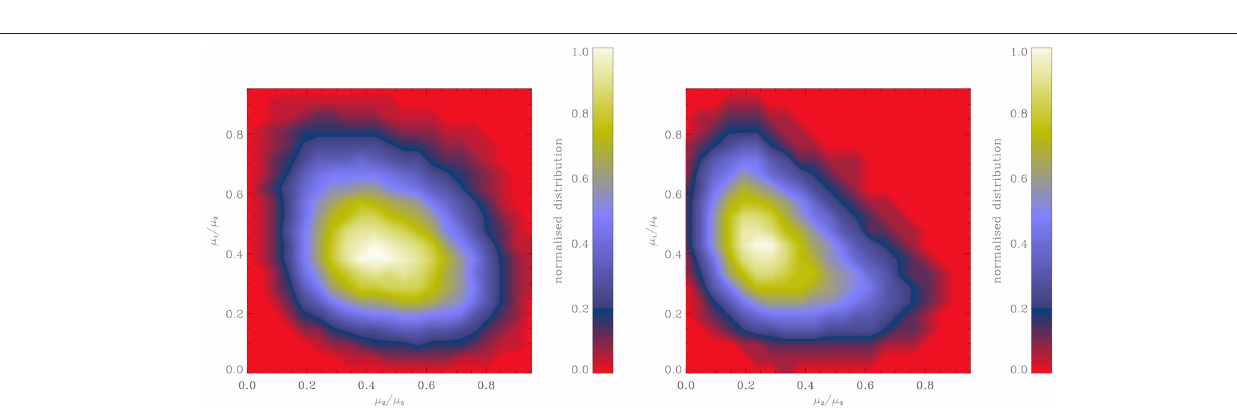
Frontiers in Astronomy and Space Sciences |